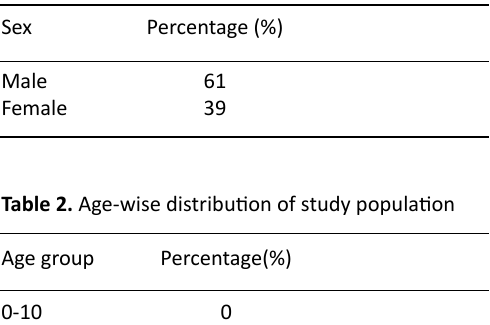
Table 1. Gender-wise distribution of study population Sex